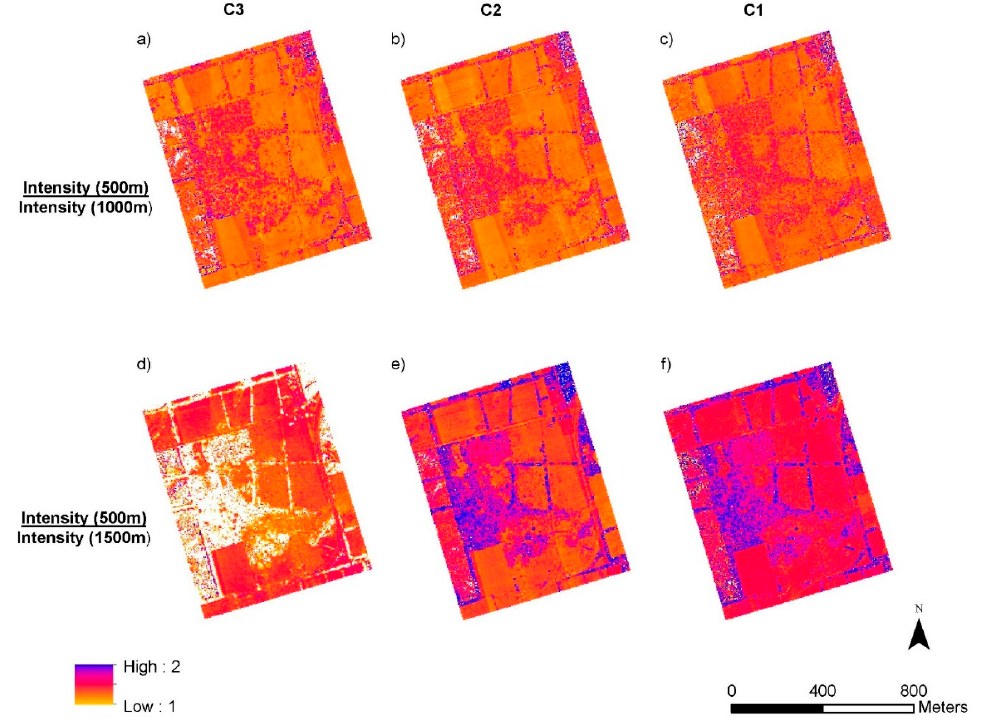
Figure 6. Single channels ratios of normalized to range 1000 m average intensity at 4 m × 4 m grid from single returns for each channel: C i (500 m) / C i (1000 m) in top figures, and C i (500 m) / C i (1500 m) in bottom figures. The channels are presented from left to right: C3, C2, and C1. White pixels represent no data.